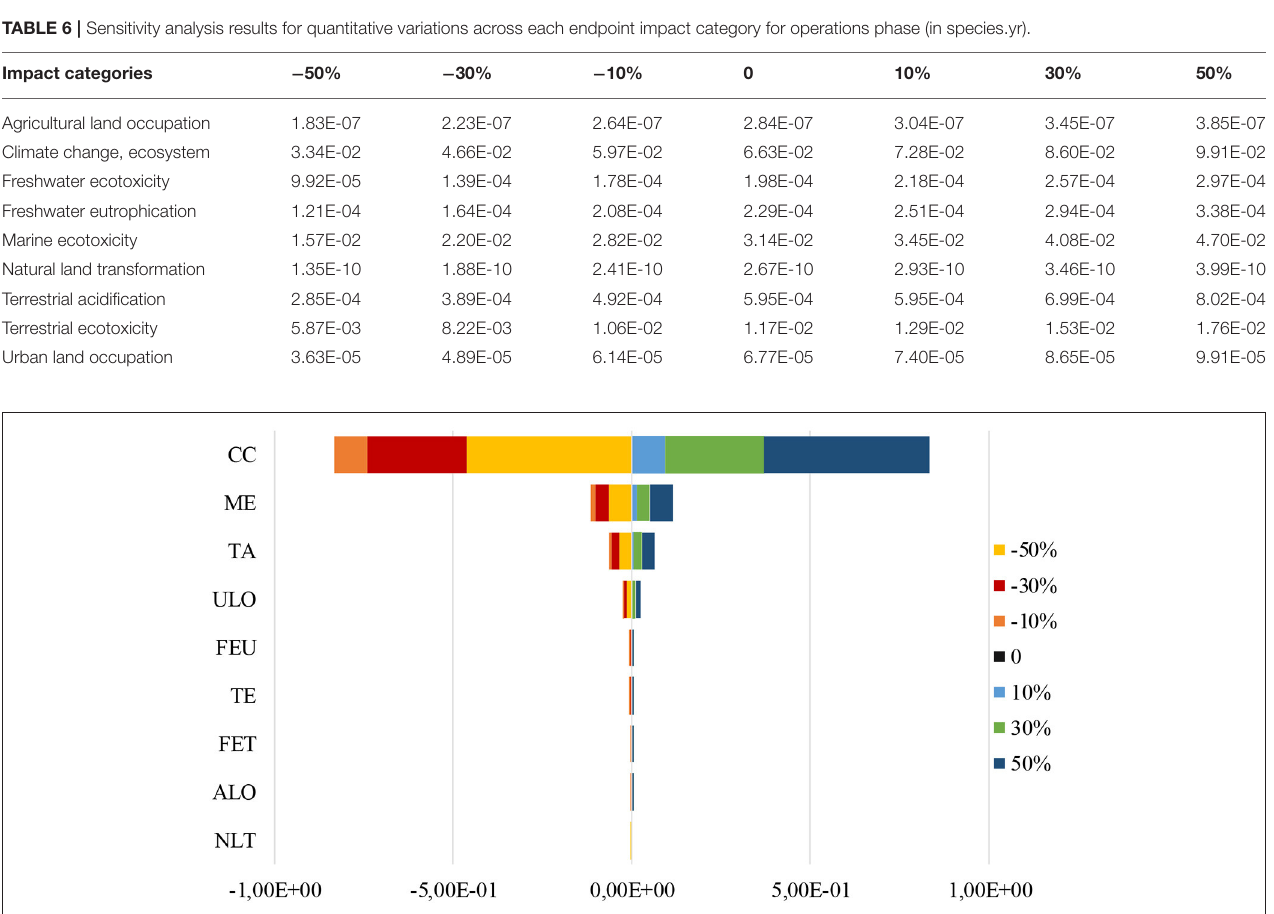
FIGURE 6 | Sensitivity analysis results across environmental influence categories due to changes in item volume in the construction